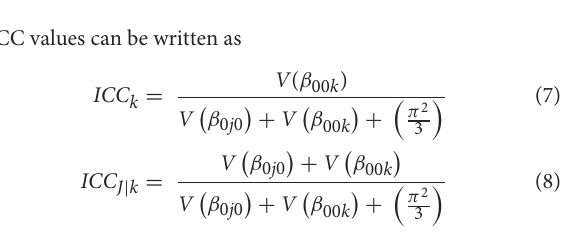
(administrative divisions) with π ijk =